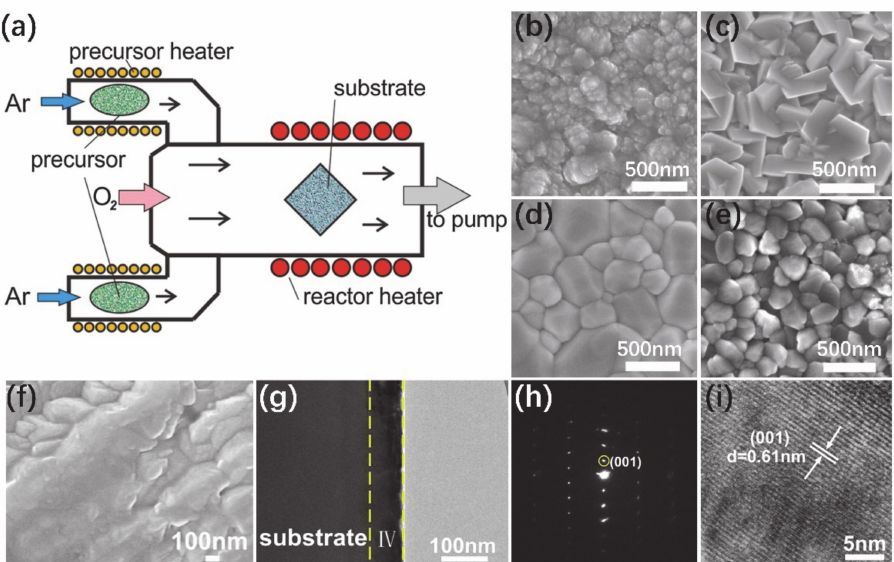
Figure 8. ( a ) Scheme of the CVD method for VO 2 film growth. ( b – e ) SEM images of VO 2 films deposited at various substrate temperatures. Reproduced from [75], with permission from Springer Nature, 2017. ( f ) SEM image of Mo-Al co-doped VO 2 (B) thin films. ( g – i ) Cross-sectional TEM and SAED patterns and the corresponding HRTEM images. Reproduced from [76], with permission from Elsevier,